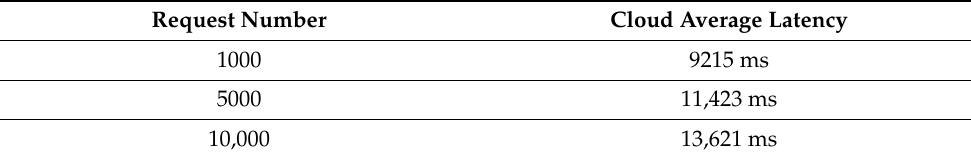
Table 4. Average Latency using Cloud Computing for 1000, 5000, 10,000